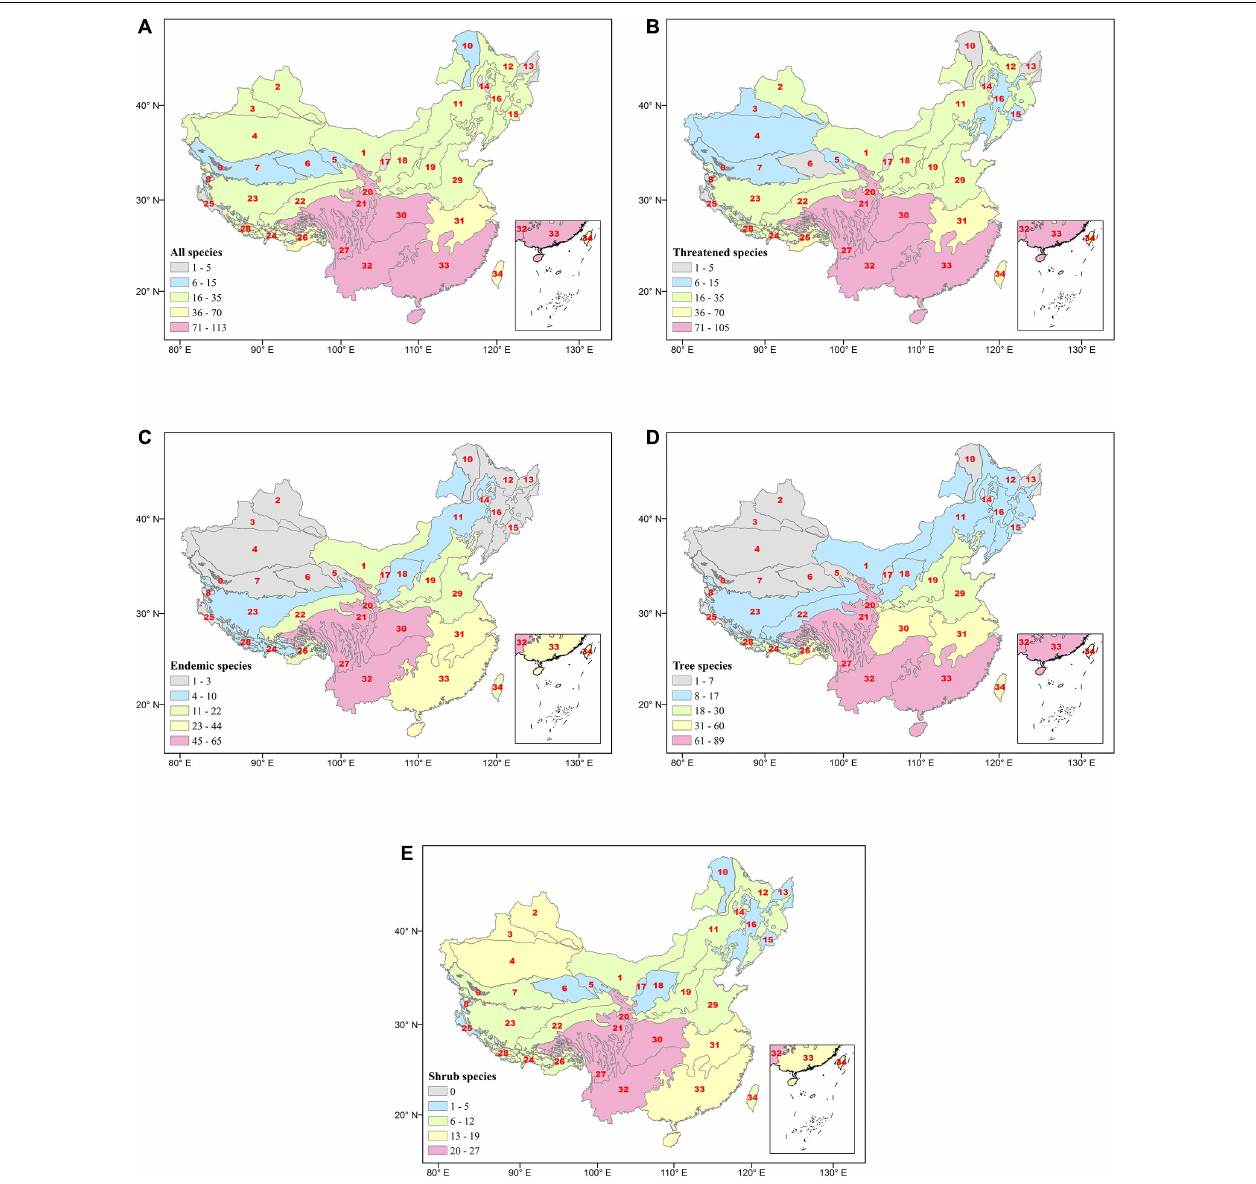
FIGURE 3 | Species distribution of gymnosperms along ecoregions— (A) all species, (B) threatened, (C) endemic, (D) tree, and (E) shrub species. The numbers in the red color indicate the ecoregion designation number referred to Figure 1 .